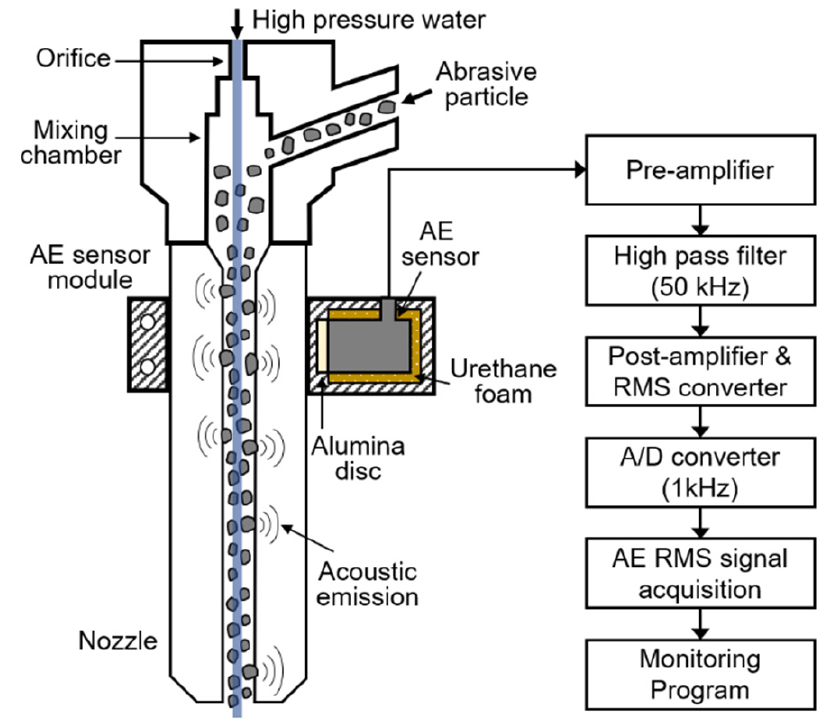
Figure 1. Schematic of the nozzle condition monitoring system using AE RMS values.